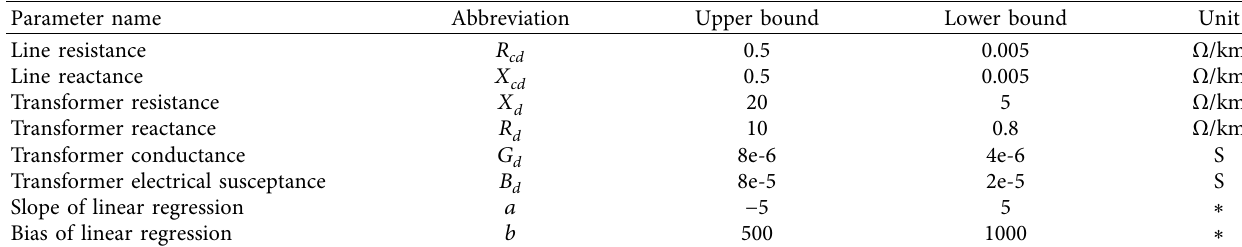
Table 1: The upper and lower bounds of MCMC and